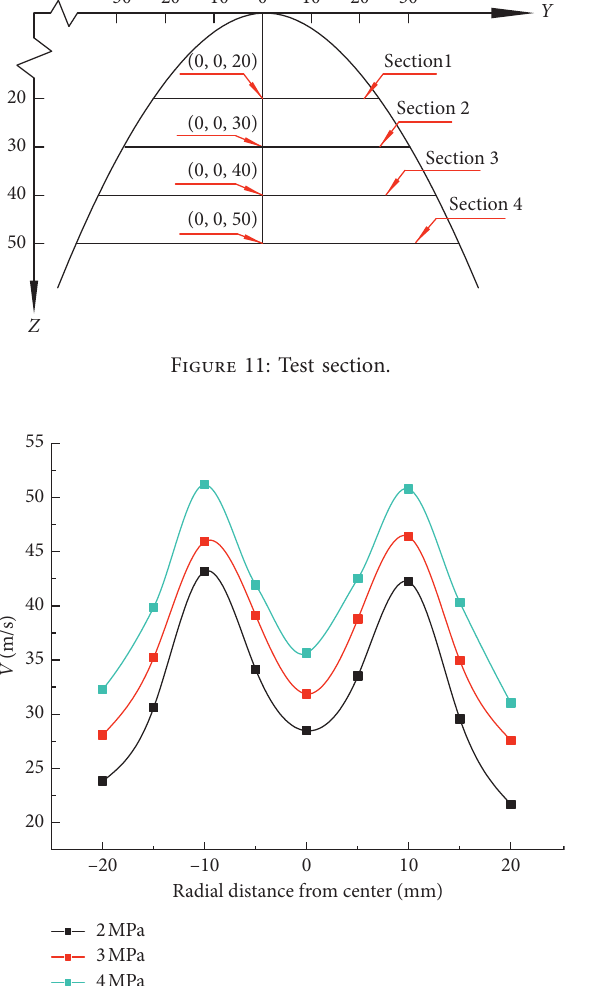
Figure 12: Radial velocity curve of Section 1.